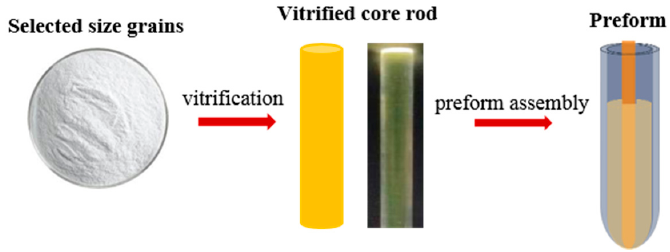
Figure 2. Schematic of powder vitrification and preform assembly.